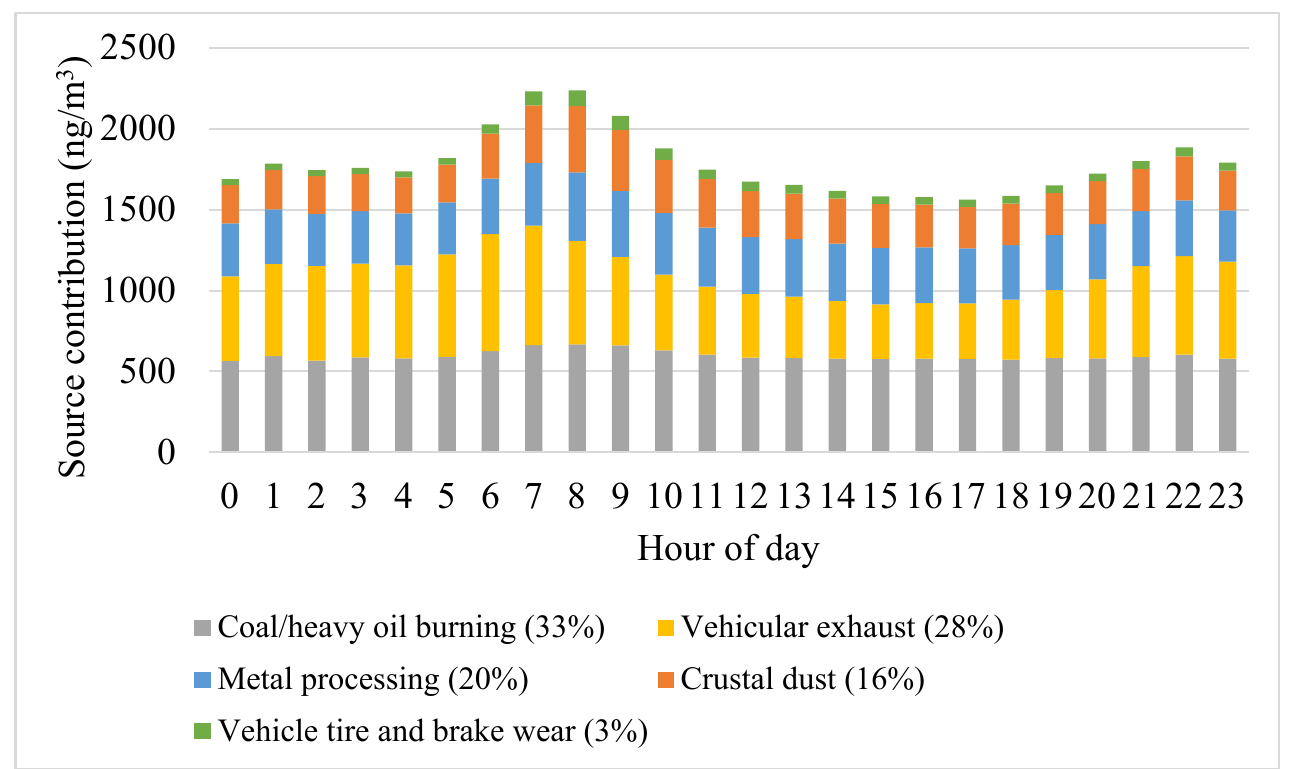
Figure 4. Diurnal variations in source contributions to ambient PM 2.5 -bound elements. Source contributions by wind direction are shown in Figure S12. Contributions The three traffic-related sources, i.e., vehicular exhaust, crustal dust, and vehicle tire and brake wear, showed clear and similar diurnal variations. The contributions peaked in the morning between 6:00 and 9:00 owing to rush hour traffic and were low in the after- noon between 16:00 and 17:00 due to increased atmospheric mixing heights. The hour-of- day averaged contributions of vehicular exhaust ranged from 360 ng/m 3 at 14:00 to 740 ng/m 3 at 7:00. A similar diurnal pattern was also observed for crustal dust (223 ng/m 3 at 4:00 to 409 ng/m 3 at 8:00) and vehicle tire and brake wear (37 ng/m 3 at 0:00 to 97 ng/m 3 at 8:00). The large diurnal variations suggest that these three sources are mostly local emis- sions. In contrast, diurnal variability in the two industrial sources (the coal/heavy oil burn- ing and metal processing factors) was small. The averaged hour-of-day contributions ranged from 570 ng/m 3 at 0:00 to 670 ng/m 3 at 8:00 for coal/heavy oil burning and ranged from 317 ng/m 3 at 23:00 to 424 ng/m 3 at 8:00 for metal processing. This suggests that these